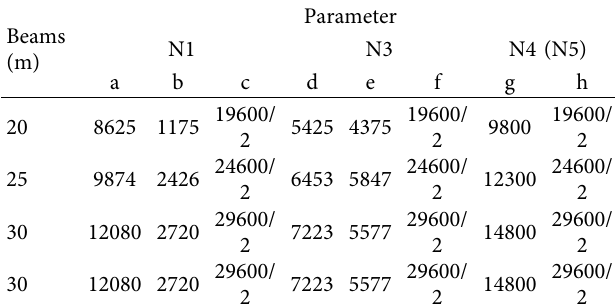
Figure 2: Distribution of prestressed monitoring points of single test beam in the process of tension. Table 2: The values of various parameters in the prestress dis- tribution diagram (unit: